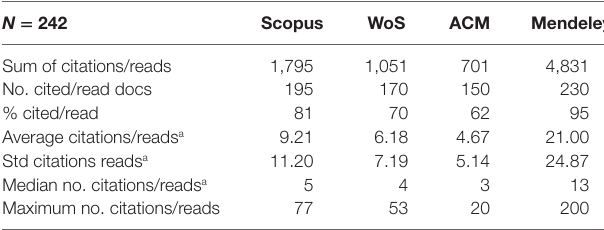
taBlE 7 | General characteristics of the documents published in 2013 and retrieved by all three databases with Mendeley reader counts